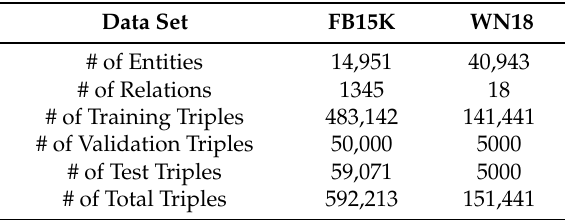
Table 4. Simple statistics on data